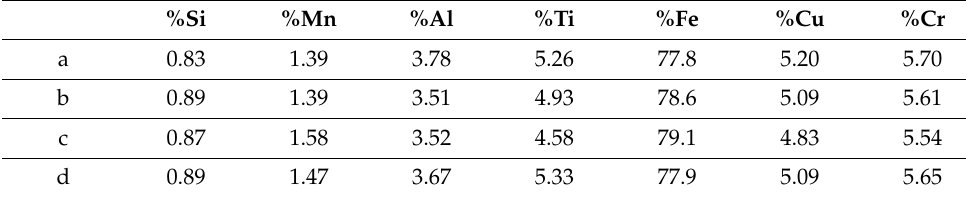
Figure 1. SEM micrograph of MP5 weld metal analysed areas (×1010). Table 4. SEM-EDS analyses of marked areas in Figure 1 (mass%).